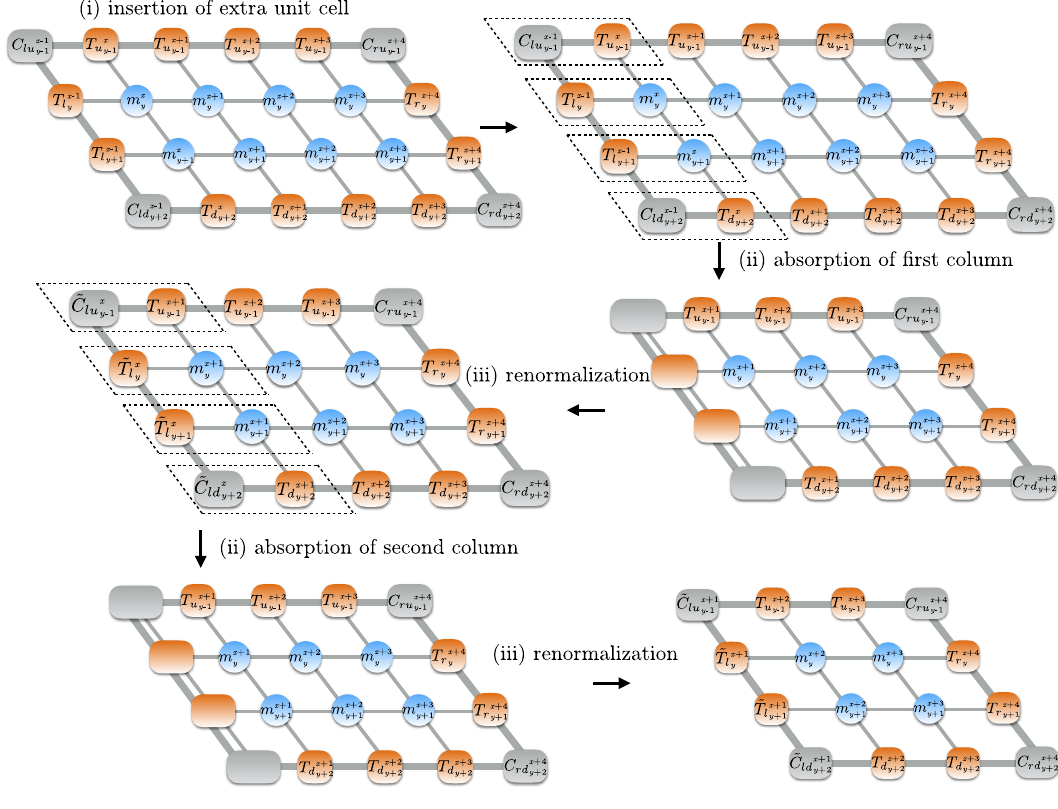
Figure 1: CTM coarse graining move to the left lattice direction: (i) extra unit cell